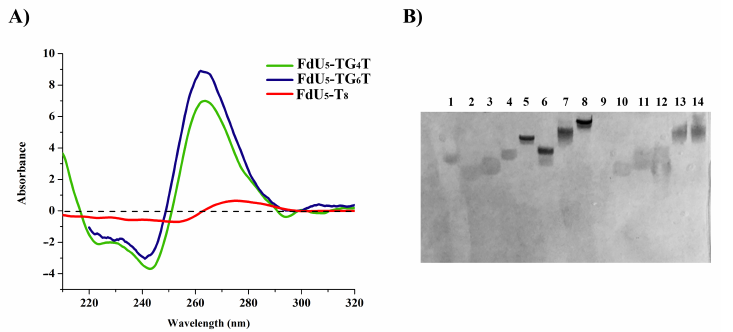
Figure 1. Characterization of the G-quadruplex structures: ( A ) Circular dichroism oligonucleotides in phosphate-buffered saline (PBS) buffer pH 7.4. ( B ) 20% Polyacrylamide gel electrophoresis analysis of Figure 2 . ( a ) UV/VIS transmittance spectra of 1 mm thin uncoated fused silica substrate ( ⁃ ⁃ ⁃ ) and fused silica coated with the structures formed upon incubation of the different DNA sequences in TBE buffer supplemented is contained in the second panel. Figuresrshould be placed in the ( a 200 nm thin ZnO-layer ( ▬ ). The dotted lines labeled T M , T m , and T E are the fits of the upper and lower envelope function with 100 mMKCl. Lanes (1) dye; (2) T 8 ; (3) T 12 ; (4) TG 4 T; (5) FdU 5 -TG 4 T; (6) TG 6 T; (7) FdU 5 -TG 6 T; as well as their geometric mean, respectively [26]. In the emission spectrum of the ZnO film ( ▬ ), λ = 325 nm was used for (8) FdU 10 -TG 6 T; (9) empty lane; (10) Fam-T 8 ; (11) Fam-T 12 ; (12) Fam-FdU 5 -T 8 ; (13) Fam-FdU 5 -TG 4 excitation. Selected emission peaks assigned to specific transitions are numbered. ( b ) Tauc plot [28] of T ZnO ( ▬ ). The linear fit ( ▬ ) at the straight portion of the band edge allows to determine E BG by the intersection at α E P = 0. ( c ) Schematic of the location of intrinsic point defect levels within the band gap by full-potential linear Muffin-tin orbital method calculations according to Xu et al. [32]. The numbers on the lines indicate Δ E P of the defect states compared to the energy of the valence band (VB)-maximum with filled ( ▬ ), partially filled (---), and empty ( ⁃ ⁃ ⁃ ) states. The positions of the energy levels are true to scale with respect to E BG = 3.26 eV. Selected transitions are labelled with dashed arrows and a number correspond- ing to the emission wavelengths in ( a ).